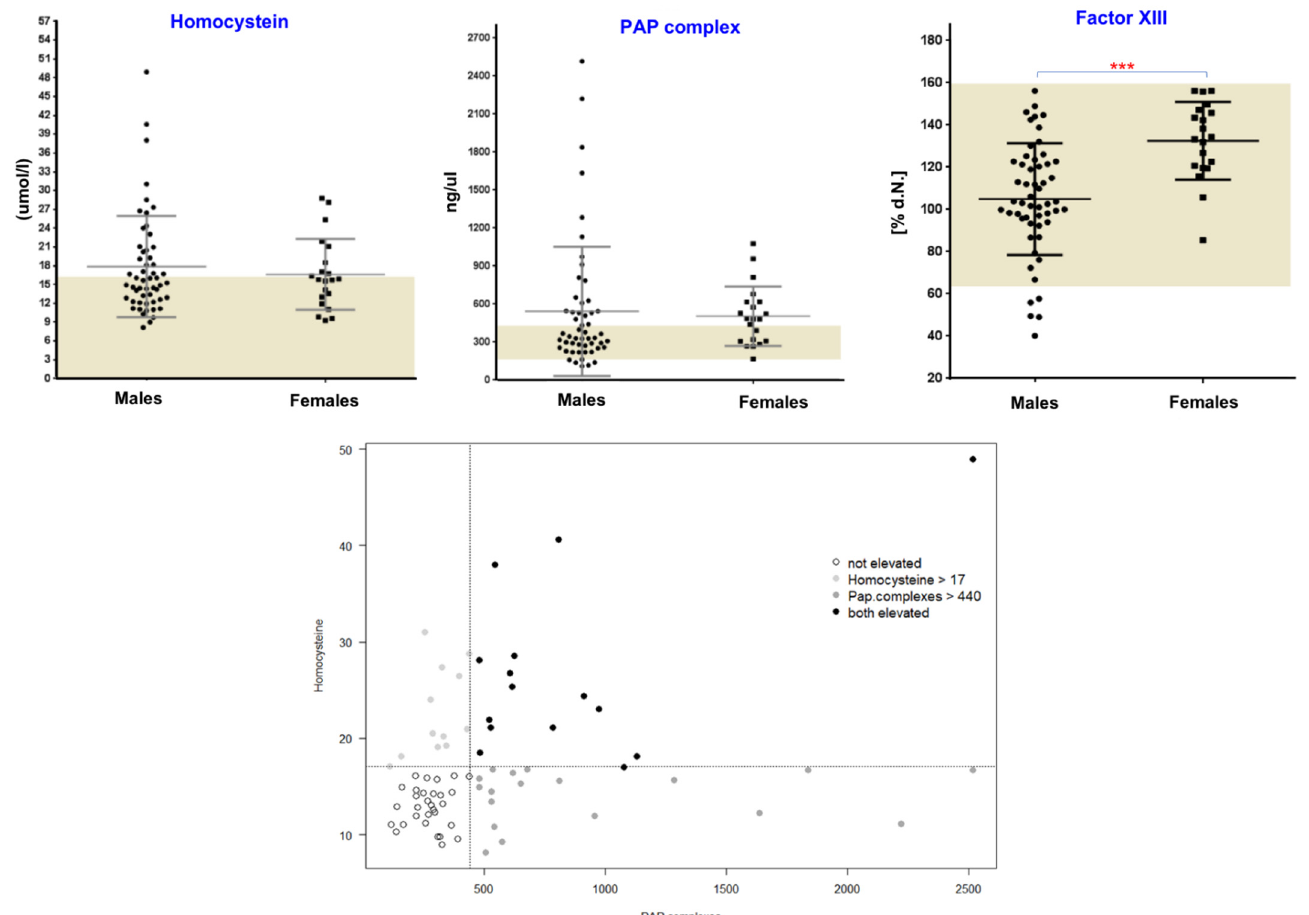
Figure 2. Evaluation of plasma homocysteine, PAP and factor XIII levels. Plots (upper section) showing values for PAP, homocysteine and factor XIII levels in PD patients. Dark bars illustrate the minimum to maximum range of levels for these markers in healthy populations. Three groups of patients with altered PAP or homocysteine levels are shown in the lower section. p -values < 0.05 were considered significant differences and are marked: * p < 0.05; ** p < 0.01; **** p < 0.0001.